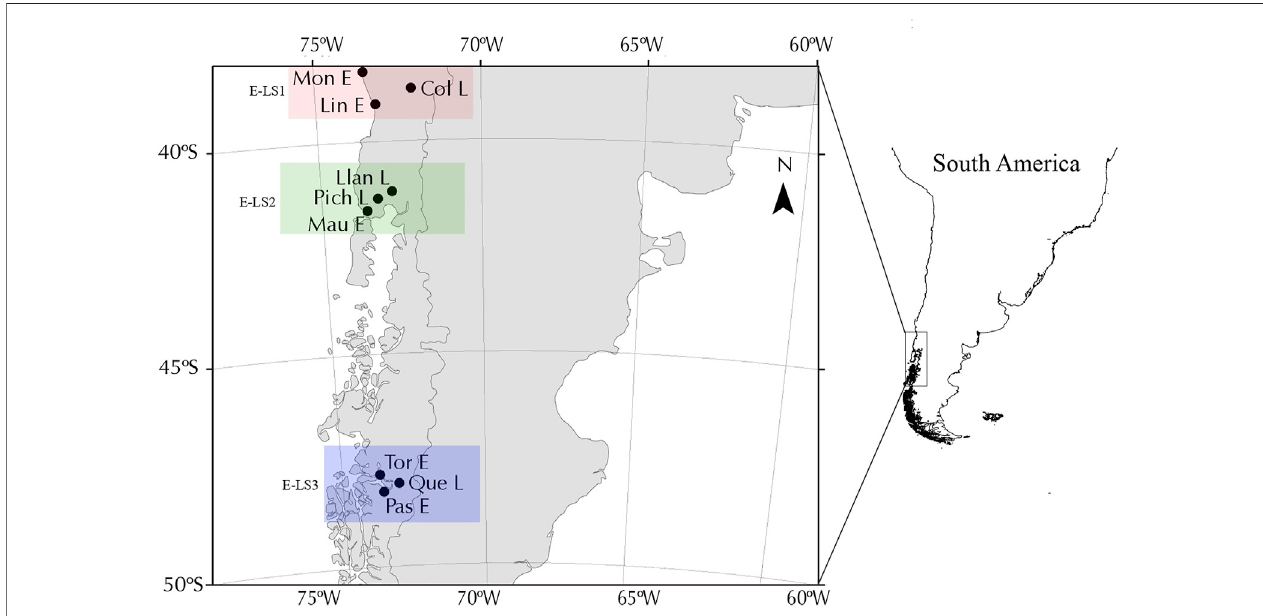
FIGURE 1 | Map showing Galaxias maculatus sampling locations in western Patagonia separated into the three systems analysed.